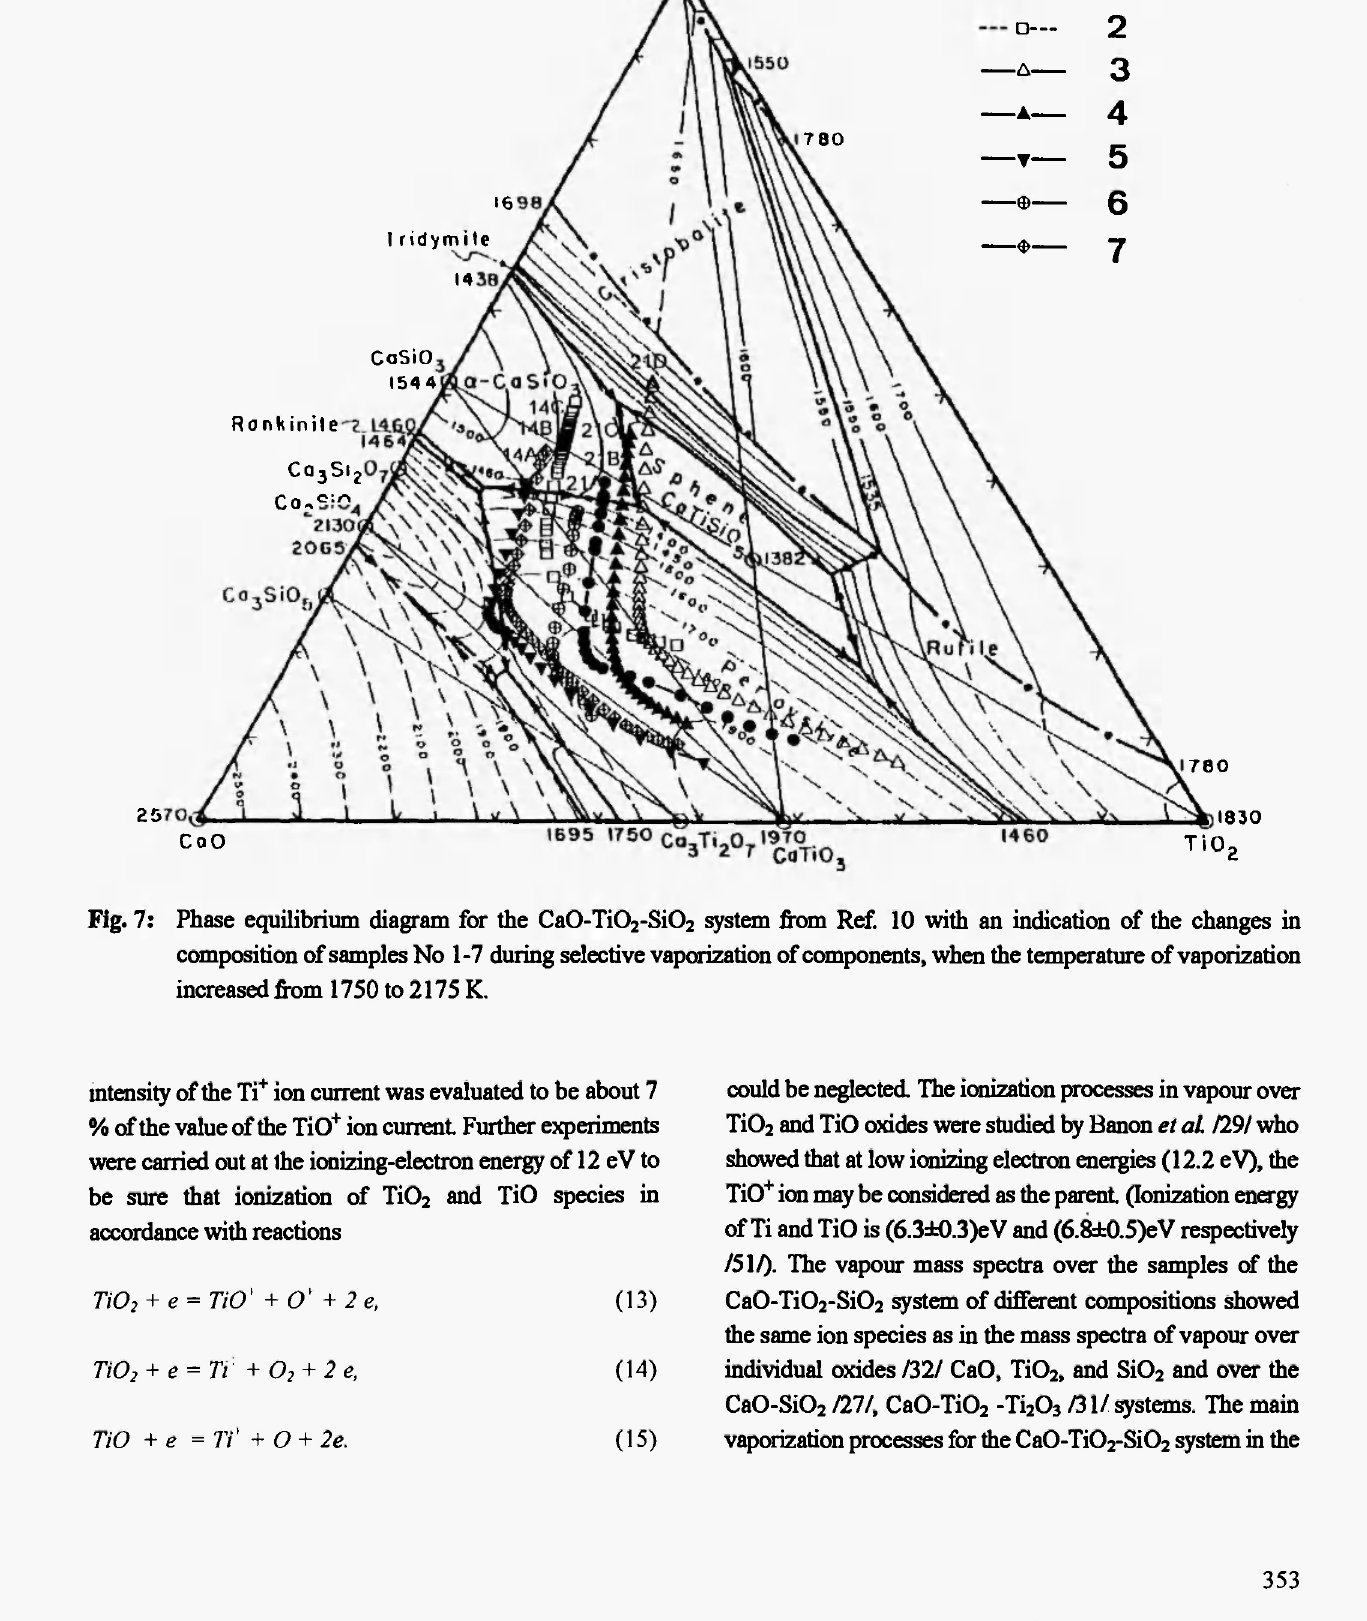
Fig. 7: Phase equilibrium diagram for the Ca0-Ti0 -Si02 system from Ref. 10 with an indication of the changes in 2 composition of samples No 1-7 during selective vaporization of components, when the temperature of vaporization increased from 1750 to 2175